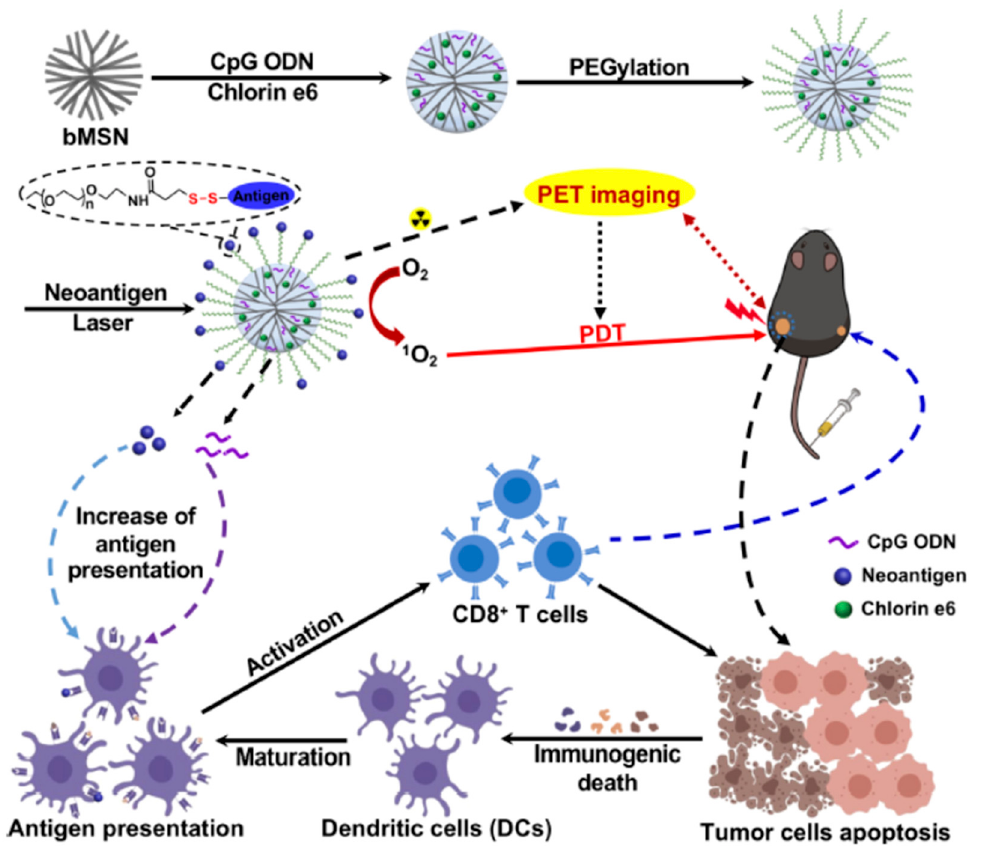
Figure 4. MSN able to induce antitumoral response by synergic effect of the release of immunostimulating agents CpG and neoantigens and PDT. The animals exhibited a significant tumor reduction even in tumors located in non-irradiated flank confirming the abscopal antitumoral effect. Reproduced with permission from [77], American Chemical Society, 2019.